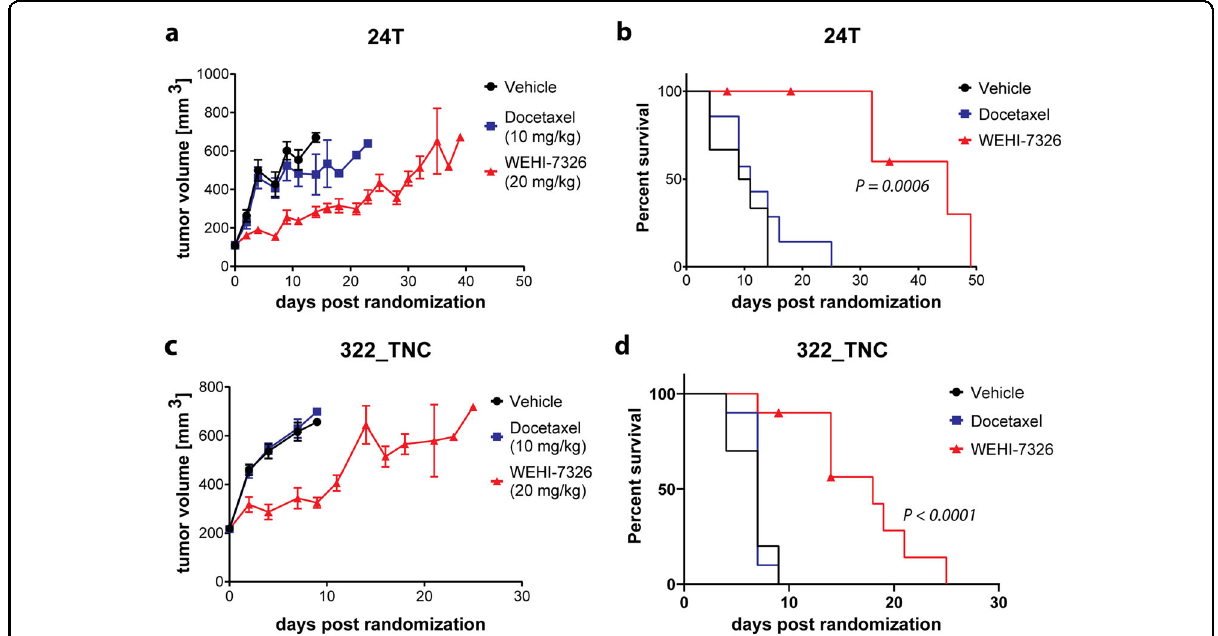
Fig. 4 Ef fi cacy of WEHI-7326 in taxane-refractory patient-derived xenograft mouse models of triple-negative breast cancer. a , b Tumor growth curve ( a ) and Kaplan – Meier survival plot ( b ) of 24 T TNBC PDX recipient female mice treated with either docetaxel (10 mg/kg, i.p.; once) or WEHI-7326 (20 mg/kg, i.v.; twice a week). p(docetaxel) = 0.3307 (ns), p(WEHI-7326) = 0.0006 (***) compared to vehicle control; p -values obtained through Log-rank (Mantel-Cox) test, n = 7 mice. Adverse effects in WEHI-7326 arm: 1 sick, 1 found dead, 1 with back leg paralysis. c , d Tumor growth curve ( c ) and Kaplan – Meier survival plot ( d ) of 322 T TNBC PDX recipient female mice treated with either docetaxel (10 mg/kg, i.p.; once) or WEHI- 7326 (20 mg/kg, i.v.; twice a week). Vehicle mice were administered the vehicle for WEHI-7326. p(docetaxel) = 0.7974 (ns), p(WEHI-7326) <0.0001 (****) compared to vehicle control; p-values obtained through Log-rank (Mantel-Cox) test, n = 10 mice. Adverse effect in WEHI-7326 arm: 1 sick, 1 found